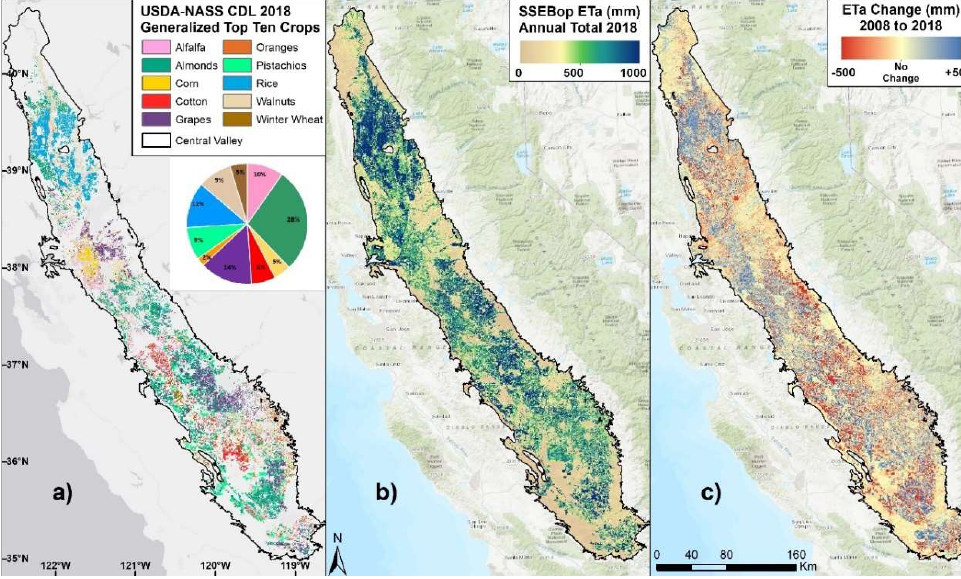
Figure 2. The Central Valley for 2018 showing ( a ) the generalized top 10 crops identified by USDA-NASS CDL, ( b ) the SSEBop annual total actual ET for 2018, and ( c ) the change in SSEBop ETa from 2008 to 2018 (2018 ETa minus 2008 ETa) .